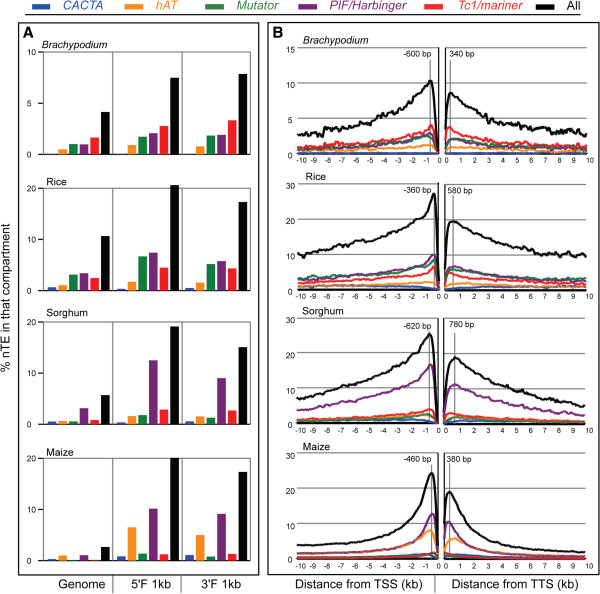
The nTE distribution in four grass genomes. A) The length percentage of nTEs in the whole genome, 1kb 5′ gene flanking regions (5′F), and 1kb 3′ gene flanking regions (3′F) of Brachypodium, rice, sorghum and maize. B) High resolution distribution of nTE frequency around the genes of Brachypodium, rice, sorghum and maize. The highest peaks of nTE frequency are marked by vertical gray lines and the distance from the peak to the TSS (transcription start site) or TTS (transcription stop site) is shown above the lines. Colors of superfamilies are the same as in Figure 
1.